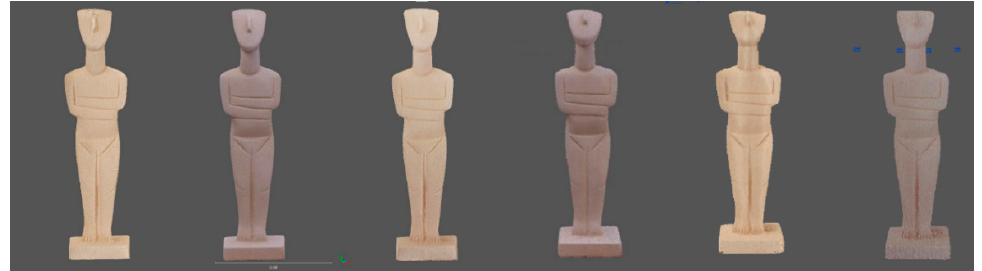
Figure 5. Textured photogrammetric meshes of the figurine copy, (from left to right) dataset 1 AMP, dataset 1 FZA, dataset 2 AMP, dataset 2 FZA, dataset 3 AMP, dataset 3 FZA.